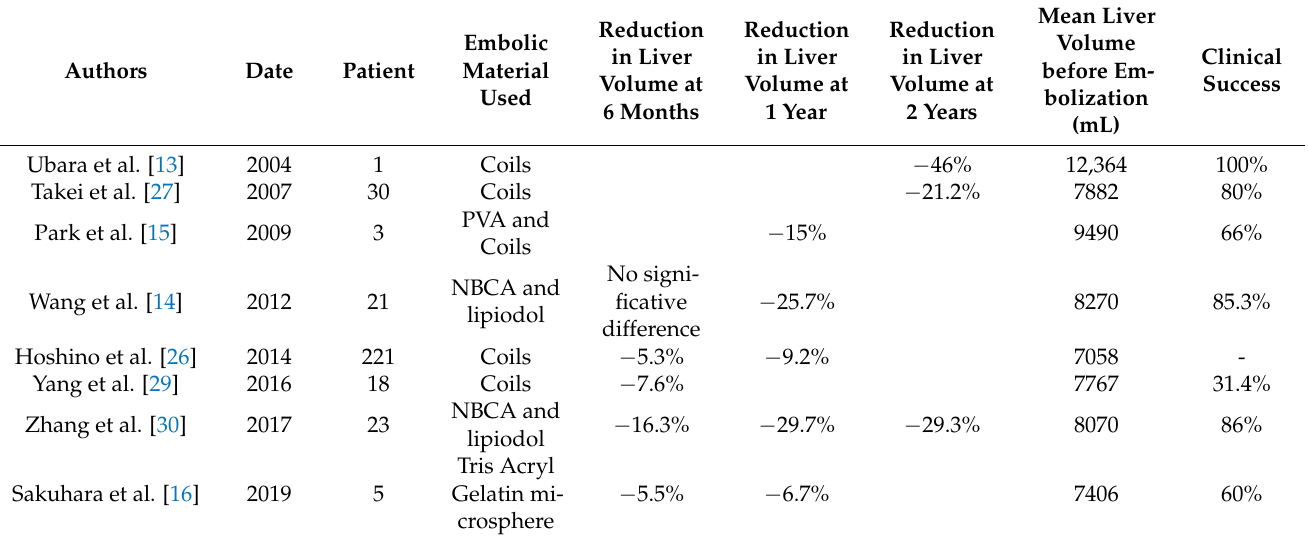
Table 5. Summary of relevant studies on hepatic artery embolization in patients with polycystic liver